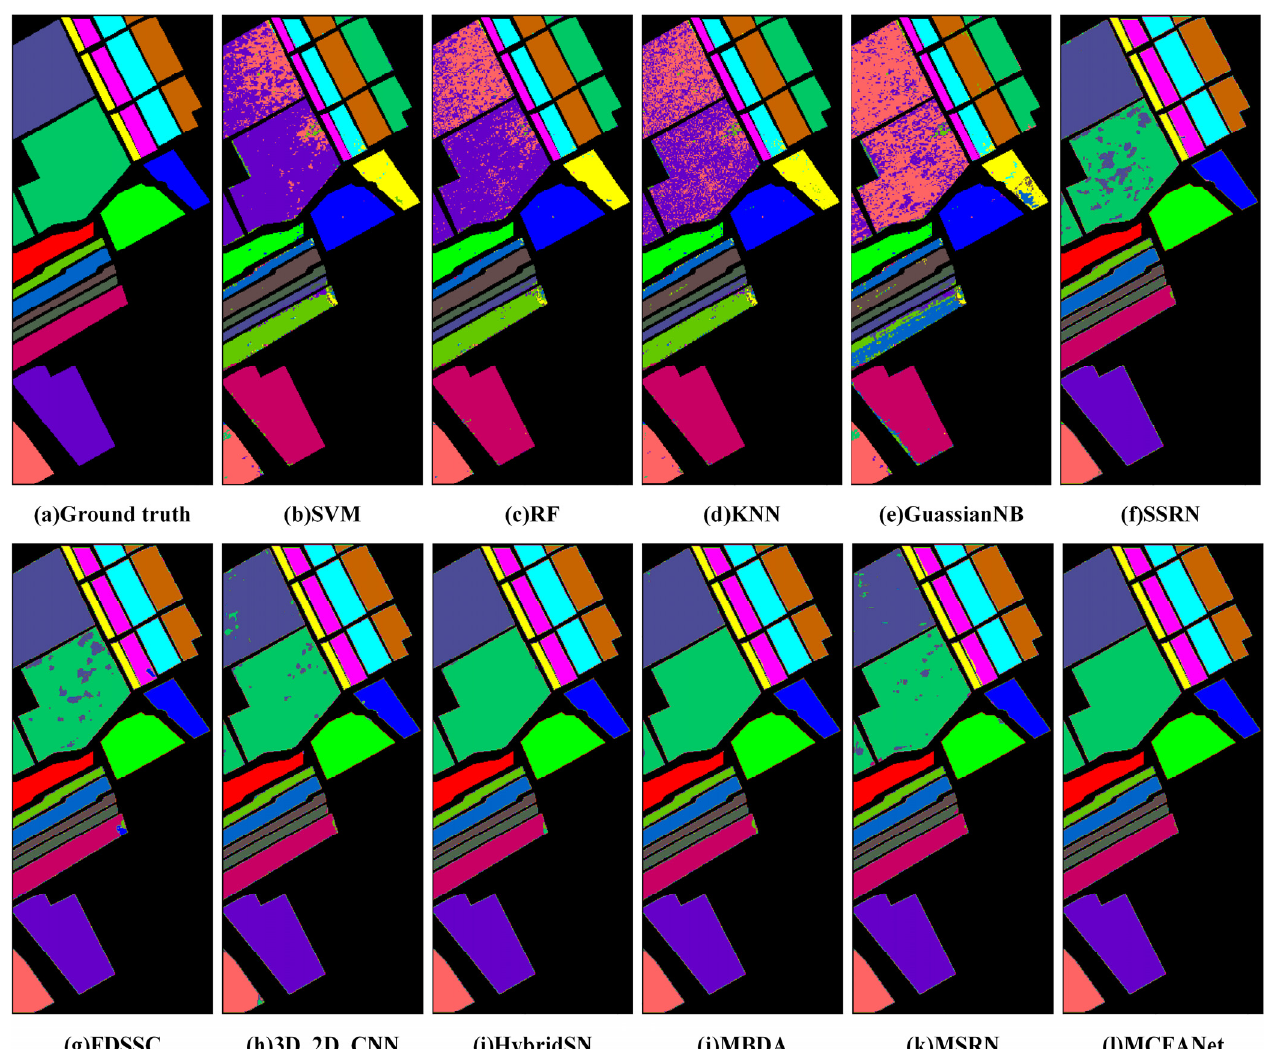
Figure 14. The visual classification maps of diverse approaches on the SA dataset.